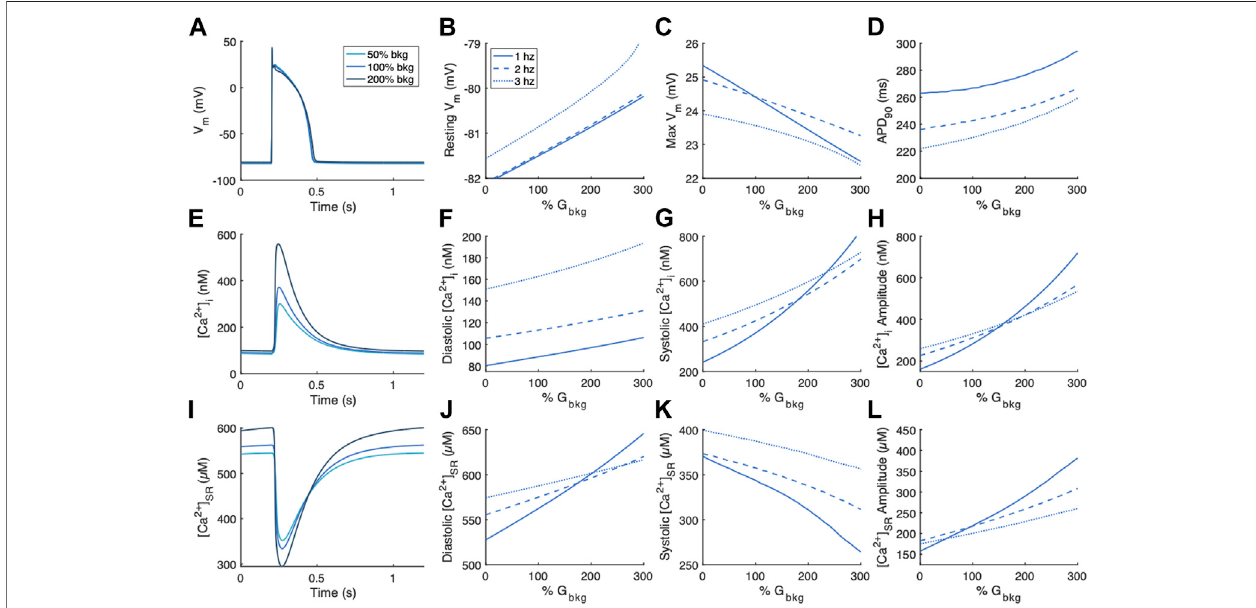
FIGURE 2 | Effects of modulating the background Ca 2+ entry current, I Cabk, on V m , [Ca 2+ ] i , and [Ca 2+ ] SR. (A) Example action potentials for 50% and 200% G bkg at 1 Hzpacing.SensitivityanalysesofmodulatingG bkg onmeasurementsof (B) restingV m , (C) maximumV m ,and (D) timeto90%repolarizationat1,2and3 Hzpacing. (E) Example [Ca 2+ ] i transients for 50% and 200% G bkg at 1 Hz pacing. Sensitivity analyses of modulating G bkg on measurements of (F) diastolic [Ca 2+ ] i , (G) systolic [Ca 2+ ] i , and (H) [Ca 2+ ] i amplitudeat1,2and3 Hzpacing. (I) Example[Ca 2+ ] SR transientsfor50%and200%G bkg at1 Hzpacing.SensitivityanalysesofmodulatingG bkg on measurements of (J) diastolic [Ca 2+ ] SR , (K) systolic [Ca 2+ ] SR , and (L) [Ca 2+ ] SR amplitude at 1, 2 and 3 Hz pacing.